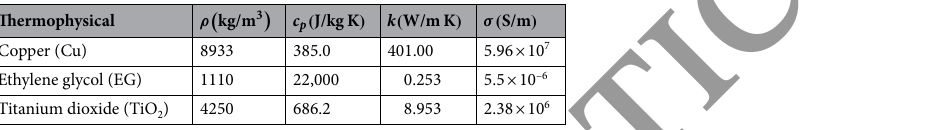
Table 3. Considerable properties of base fluid and nano sized particles at 293 K.